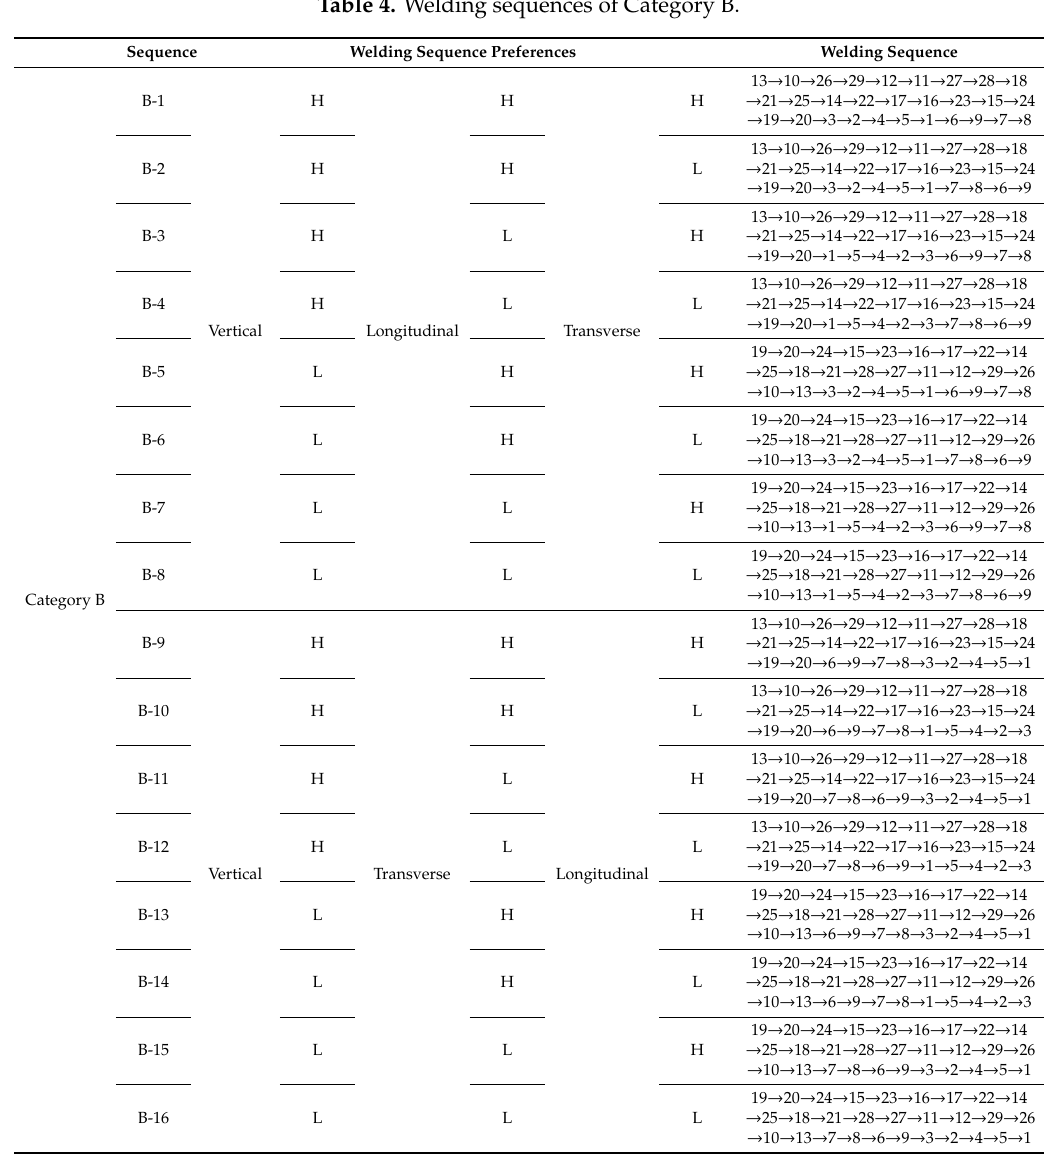
Table 4. Welding sequences of Category